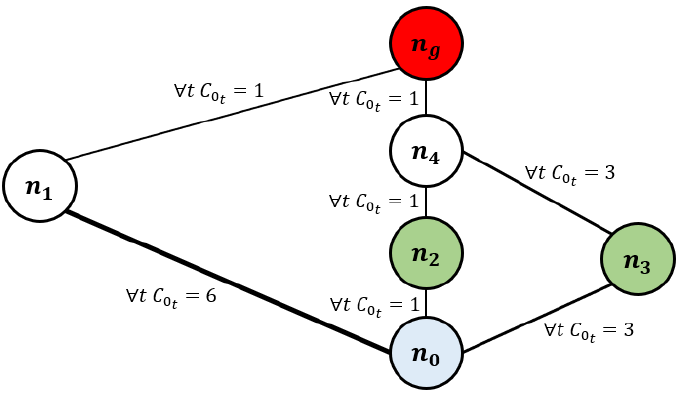
Figure 1. The navigation